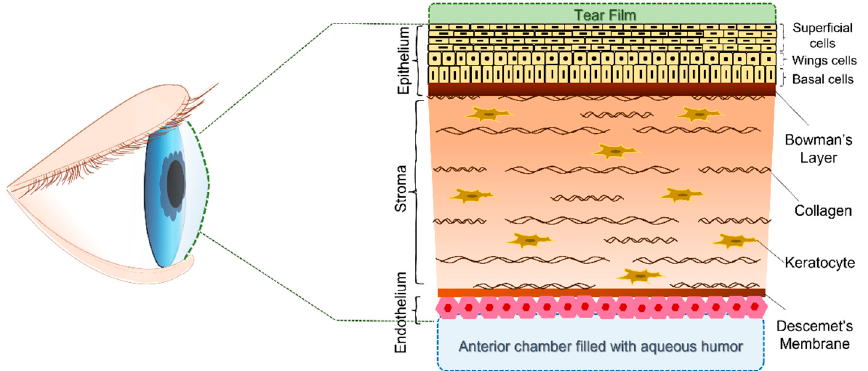
Figure 1. Schematic representation of the human cornea in cross-section. This avascular tissue is basically composed of three composite regions. The outermost anterior layer is the epithelium, which is followed by the stroma, which is the thickest layer of the cornea and is composed of keratocytes and collagen. The third portion is the endothelium, which is a monolayer of cells that lies adjacent to the aqueous humor. Bowman’s connective tissue layer and Descemet’s membrane are two acellular structures that connect the other portions of the cornea.